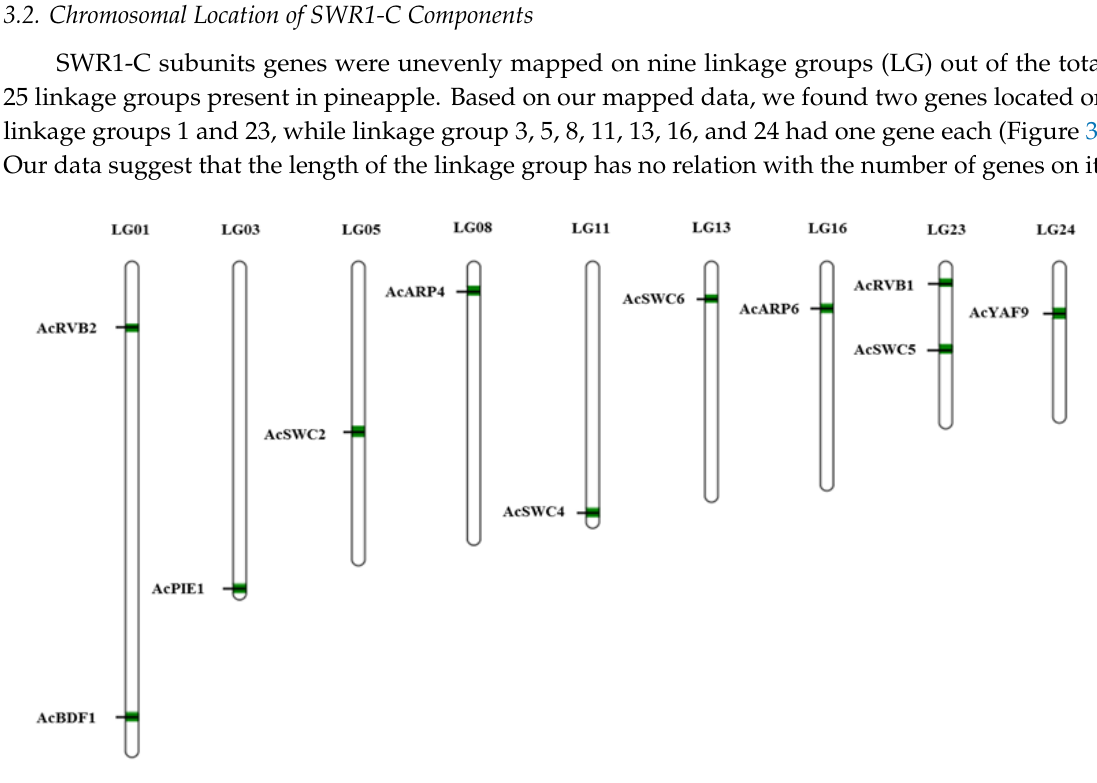
Figure 3. Chromosomal locations of pineapple SWR1-C subunits. The 11 SWR1 subunits of pineapple were mapped to different chromosomes using MapChart. The position of pineapple SWR1-C subunits are represented in green.